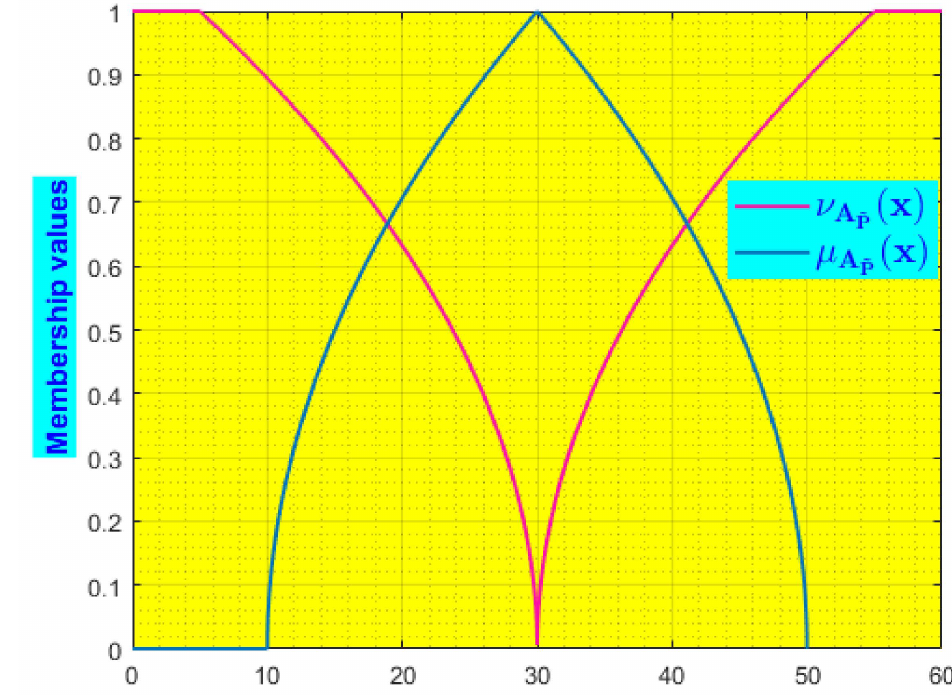
Figure 2. Graph of membership functions of